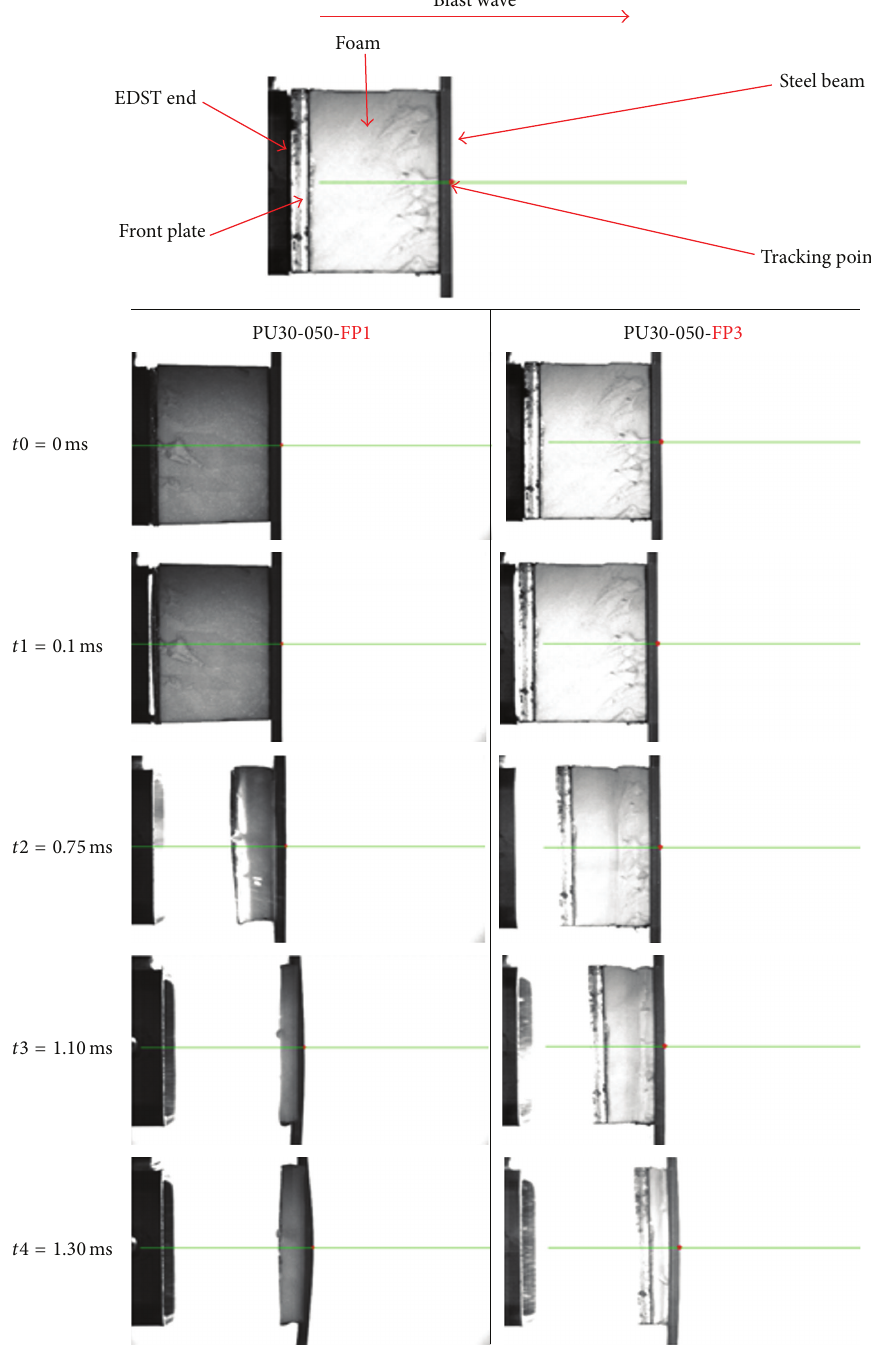
Figure 9: The chronological interaction of the simply supported beam with the tested sacrificial cladding configurations: PU30-050-FP1 and